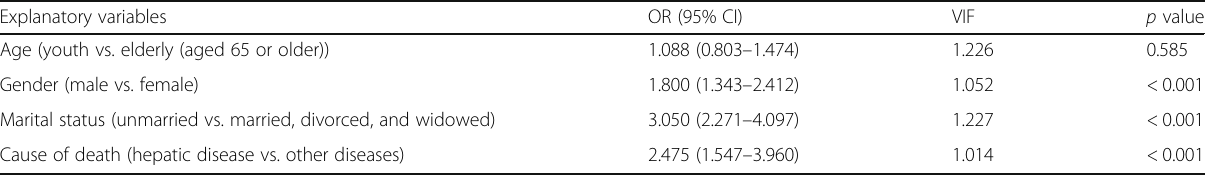
Table 2 Factors associated with postmortem interval until finding (PMI-f) by logistic regression Explanatory